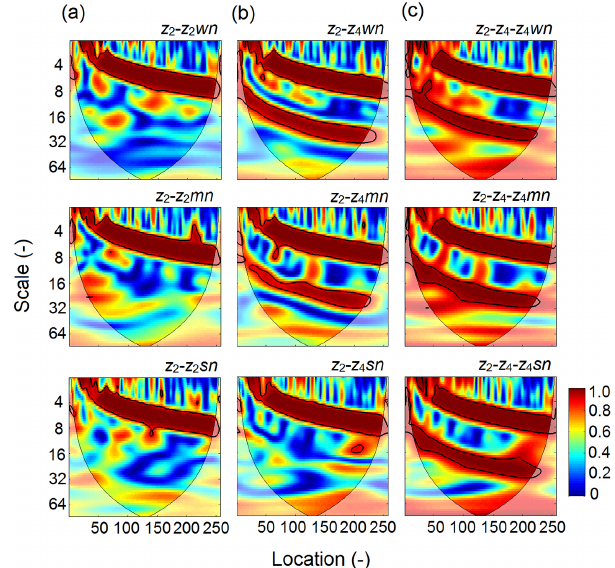
Figure 4. Multiple wavelet coherence of an artificial data series ( z ) encompassing five cosine waves ( z 1 , z 2 , z 3 , z 4 , and z 5 ) with differ- ent scales and (a) z 2 and noised z 2 , (b) z 2 and noised z 4 , and (c) z 2 , z 4 , and noised z 4 for the non-stationary case. The variables z 2 wn ( z 4 wn), z 2 mn ( z 4 mn), and z 2 sn ( z 4 sn) indicate weakly, moderately, and strongly noised z 2 ( z 4 ) series, respectively. Weakly, moderately, and strongly noised series are correlated with original series, with correlation coefficients of 0.9, 0.5, and 0.1,